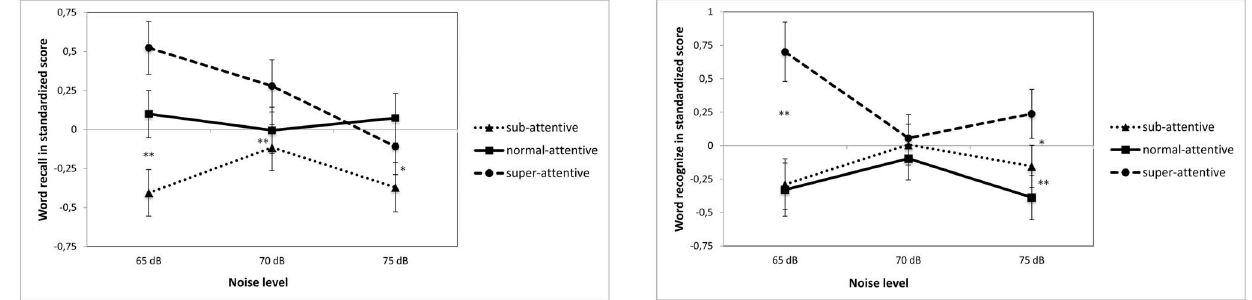
Figure 3. Figure 3A. Performance on Word recall task (non-executive) as a function of attention ability and noise level. Note: White noise levels were 65, 70, 75 dB, speech level < 75 dB; * (p , .05) and ** (p , .001) indicates significant differences between super- and sub-attentive groups. Figure 3B. Performance on Word recognize task (non-executive) as a function of attention ability and noise level. Note: White noise levels were 65, 70, 75 dB, speech level < 75 dB; * (p , .05) and ** (p , .001) indicates significant differences between super- and sub, normal-attentive groups in 65 and 75 dB conditions.